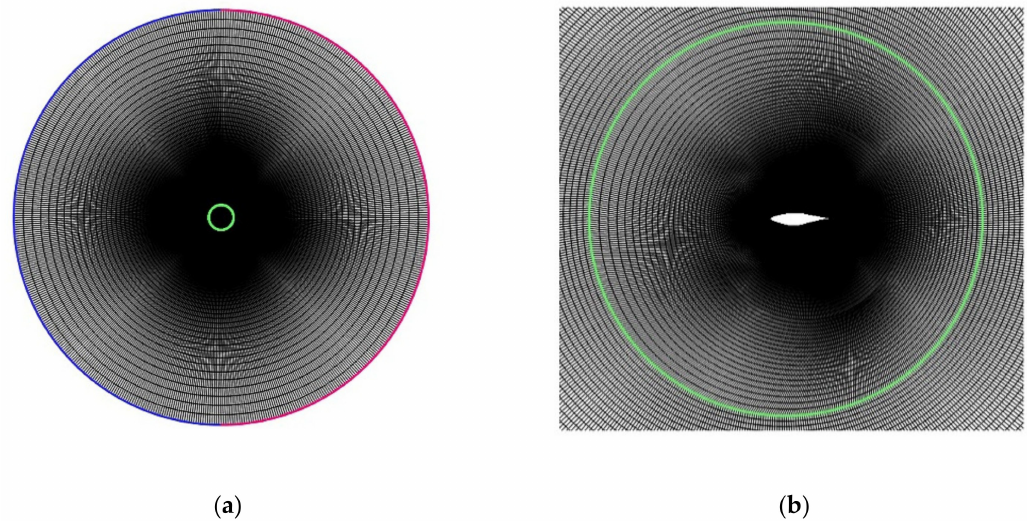
Figure 1. Computational field and mesh: ( a ) the blue and red semicircle edges are the velocity-inlet and pressure-outlet boundaries, respectively; ( b ) the green circle edge is the interface between the stationary domain and the rotating domain.